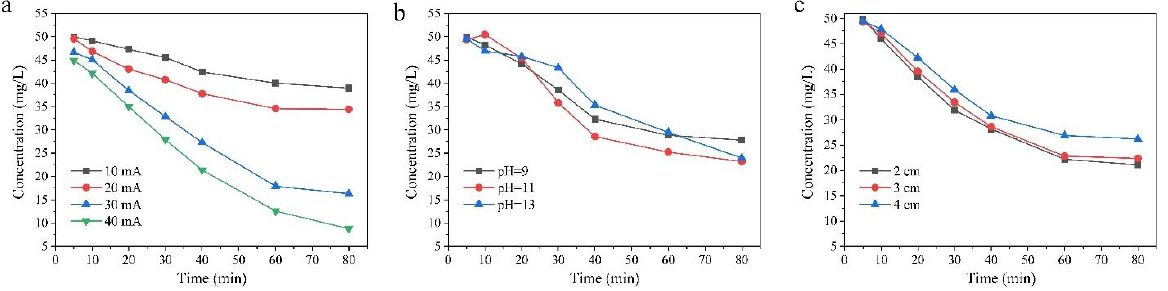
Figure 5. Influence of the current density ( a ), pH ( b ), and the inter-electrode distance ( c ) on norfloxacin removal on the PbO 2 -FN electrode (the initial concentration of norfloxacin = 25 mg/L; T = 30 °C; the concentration of Na 2 SO 4 = 0.05 mol/L).